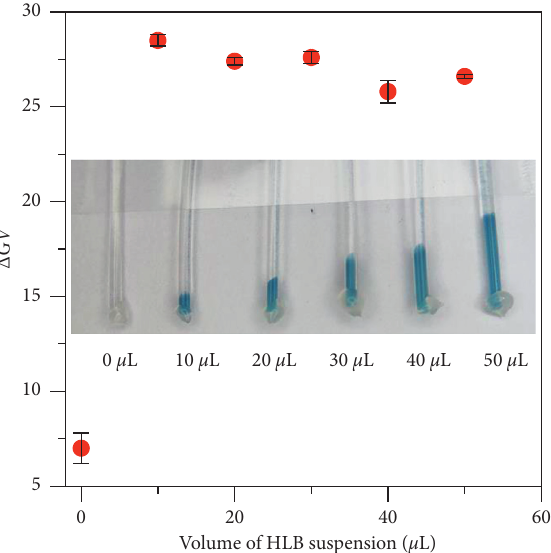
Figure 5: Effect of HLB suspension volume on the color intensity of 2.5 μ M standard ( n ˆ 3).